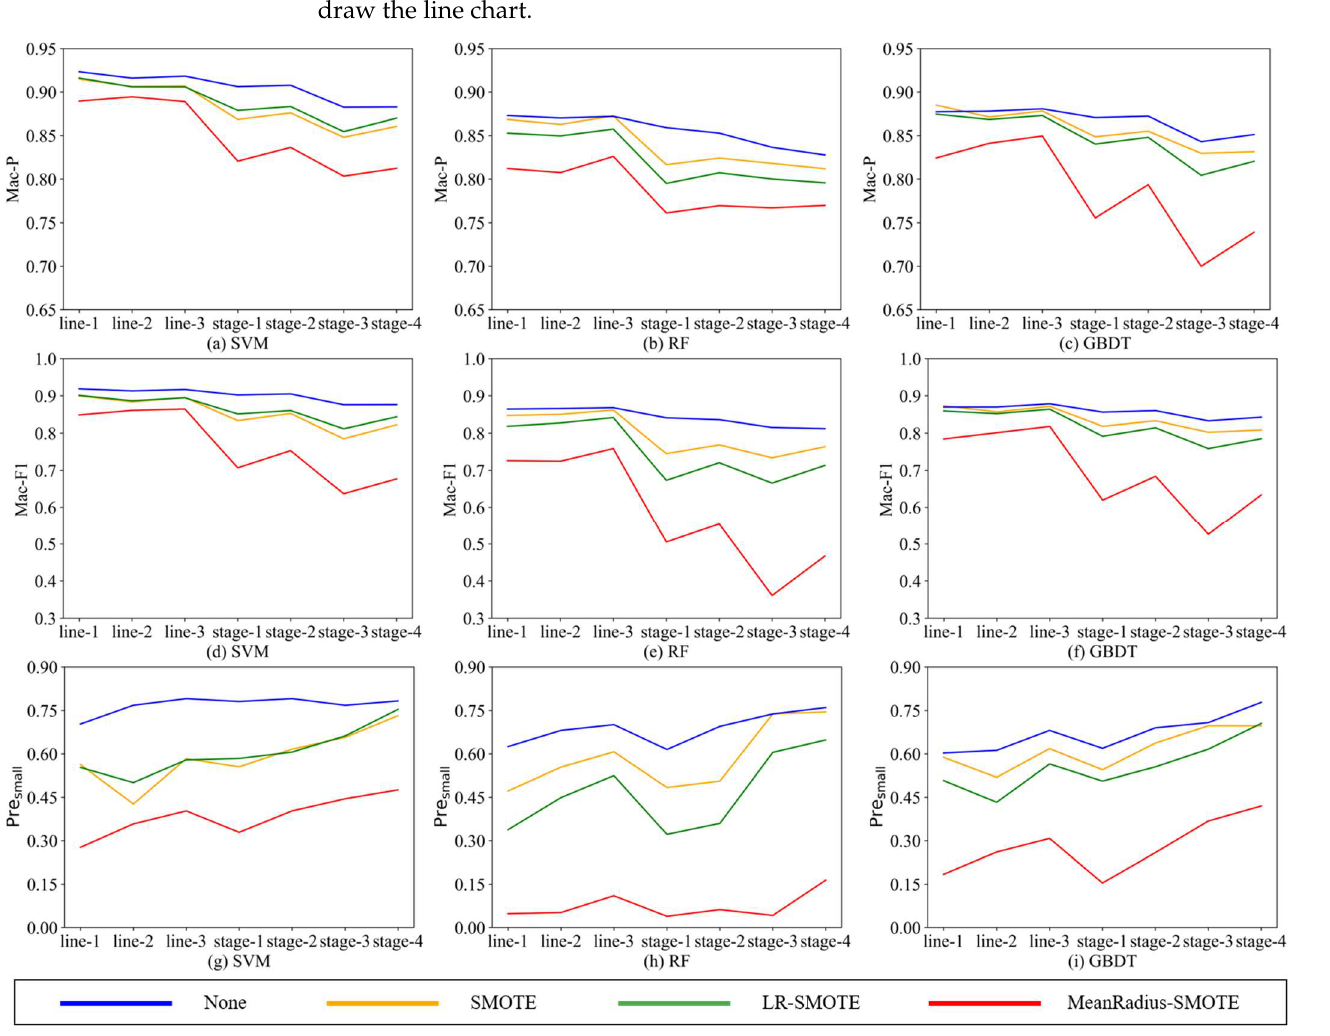
Figure 6. The line charts of Mac-P, Mac-F1, and Pre small .